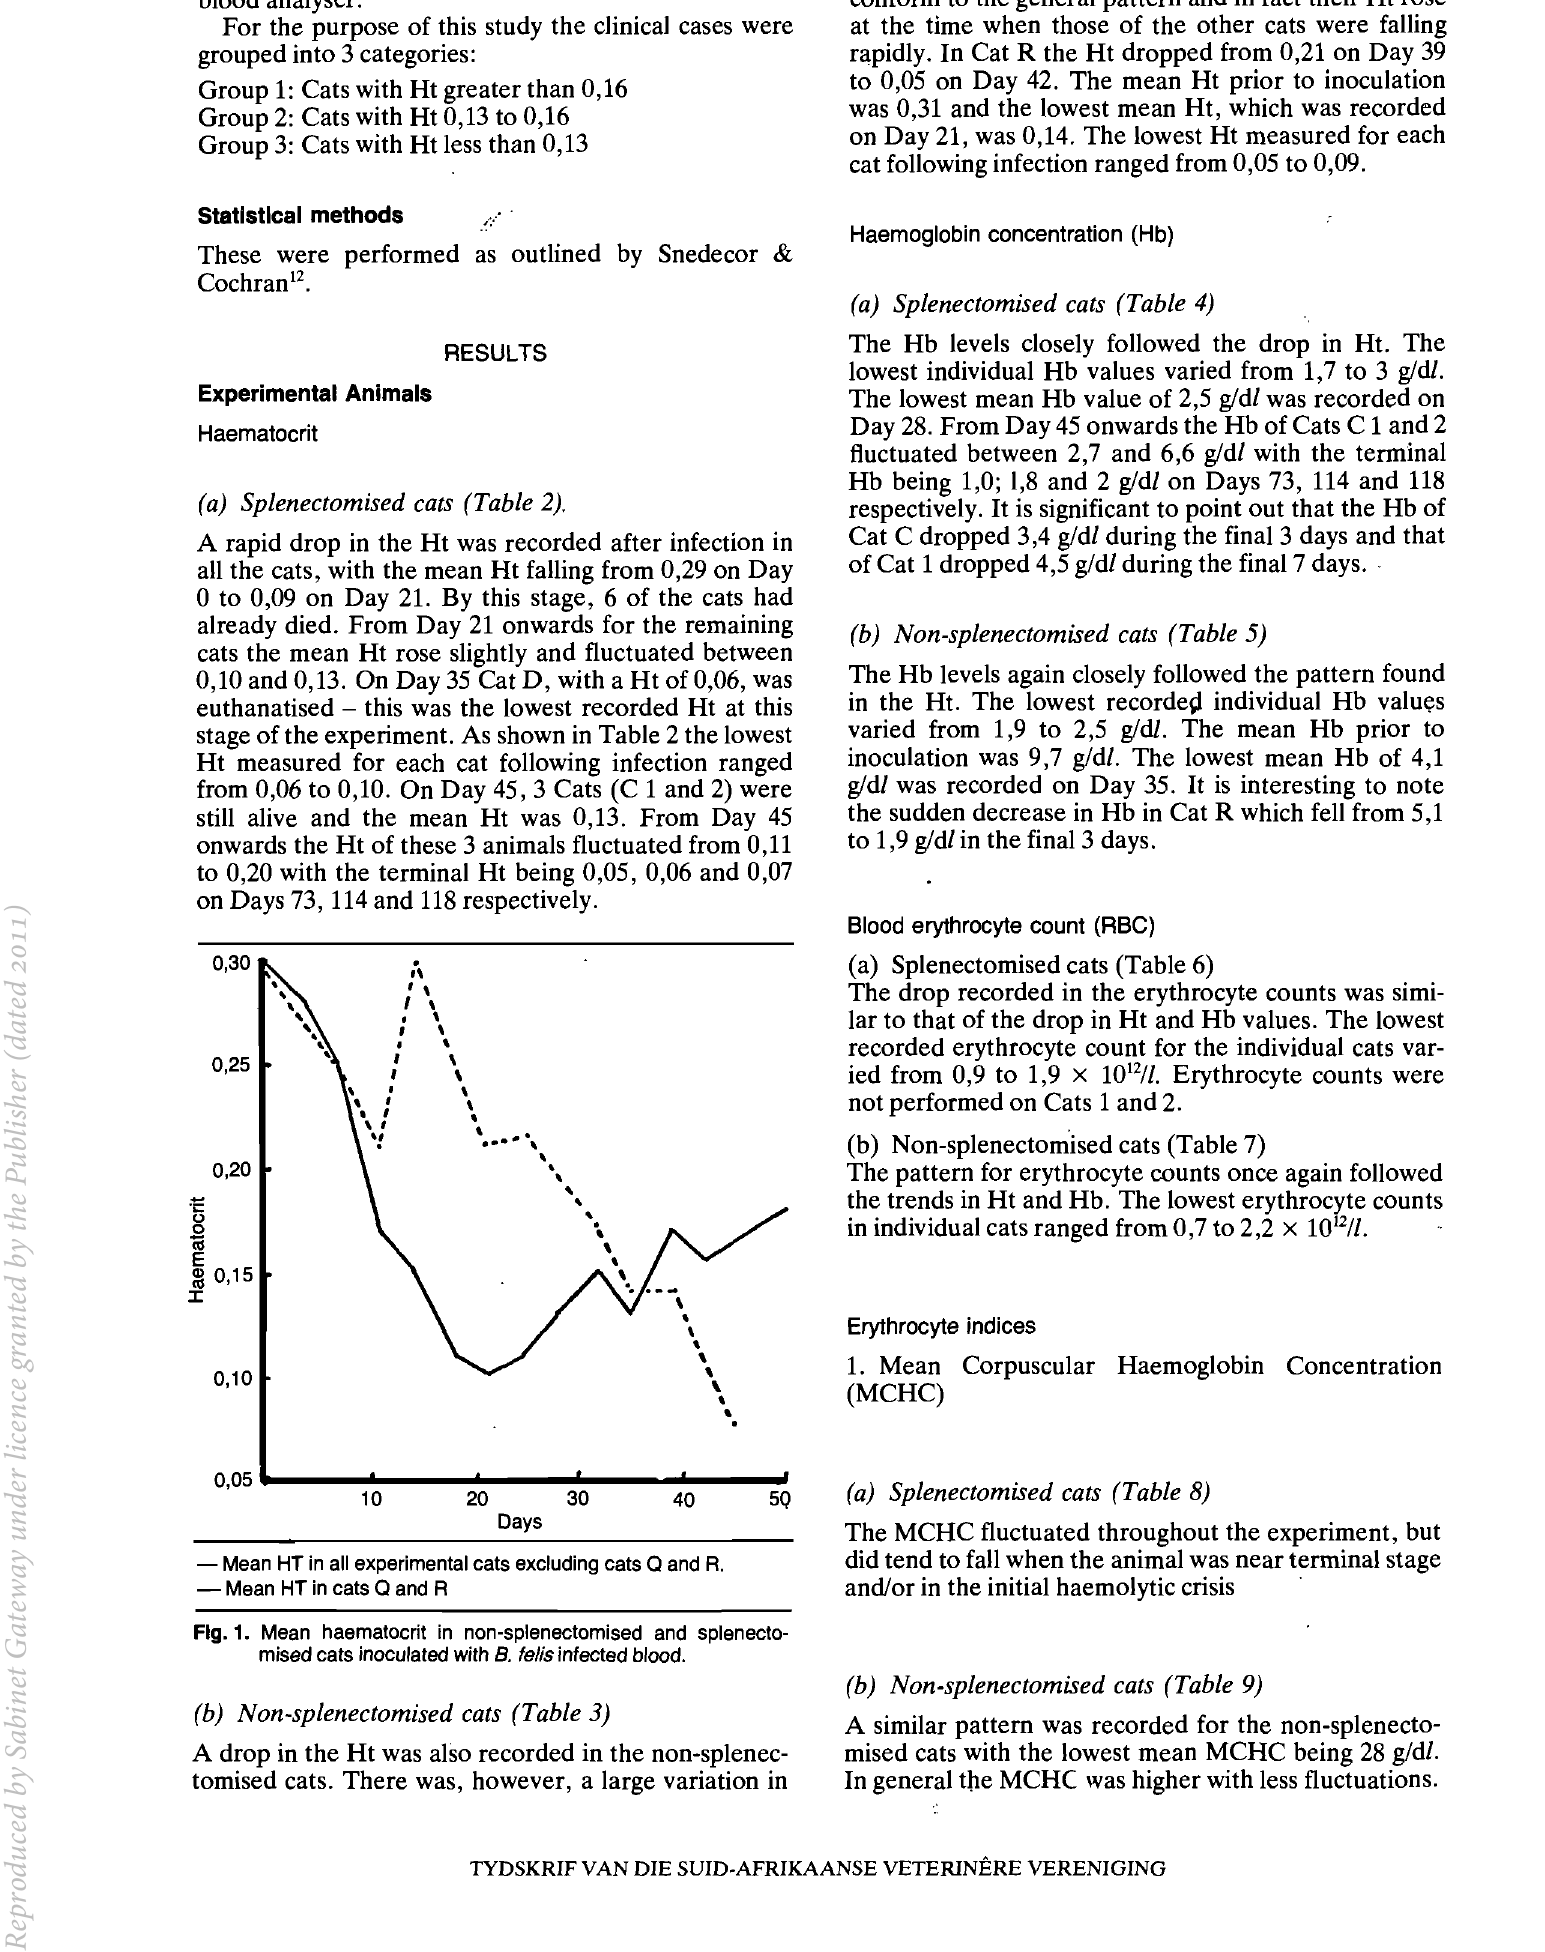
(a) Splenectomised cats (Table 4)